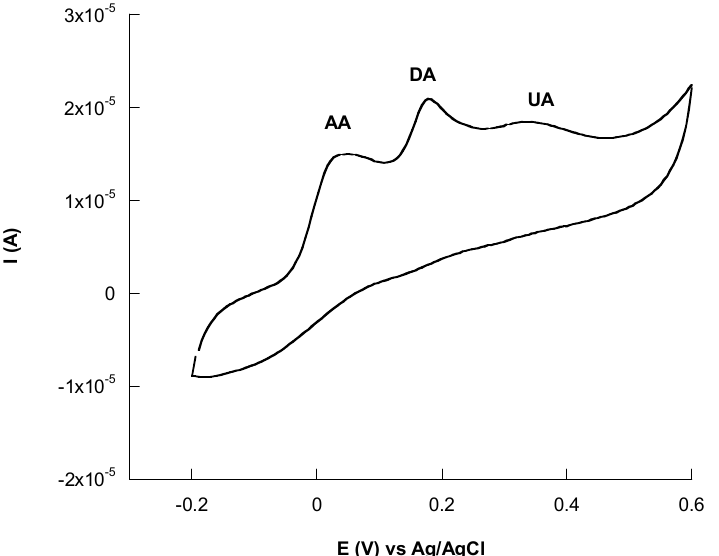
Figure 9. Cyclic voltammograms of AA 4 mM + DA 3 mM and UA 6 mM at h-nPG electrode in 0.1